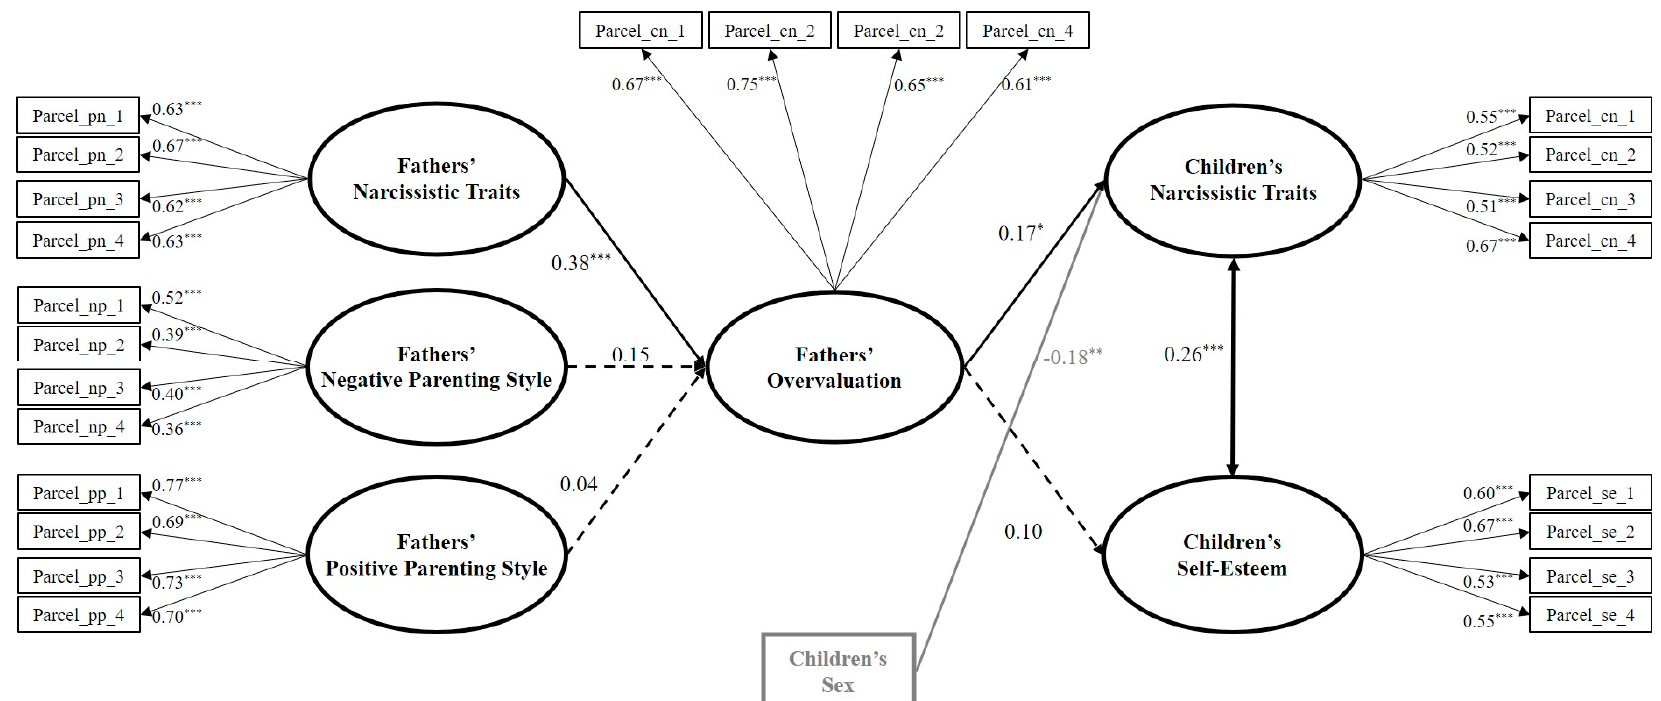
Figure 4. Estimated structural equation model for the best fitting mediation model among the father–child dyads. N = 442. Standardized regression coefficients (betas) are shown. The measurement part of the model (including the parcels and factor loadings) is presented in black. The key study latent variables and their related paths are presented in bold black. Sex, as the control variable, and its related paths are presented in bold gray. Solid lines represent significant paths and dashed lines represent non-significant paths. For better visualization, residuals and non-significant covariances are not shown. The standardized indirect effect of the fathers’ narcissism on children’s narcissism through the fathers’ overvaluation was β = 0.06, p = 0.03. * p < 0.05, ** p < 0.01, *** p < 0.001.